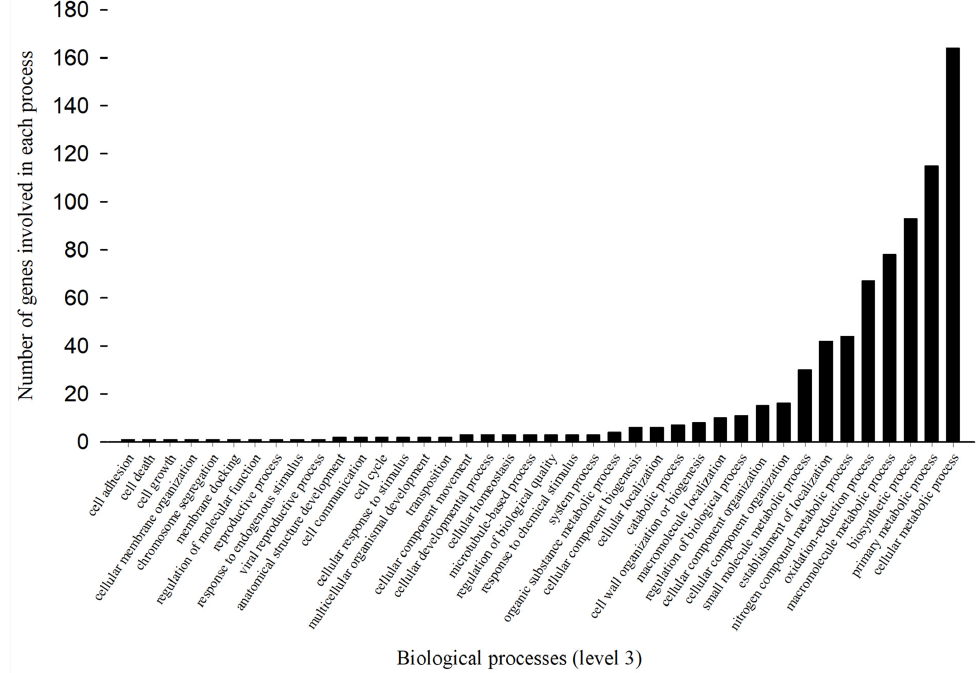
Figure 2. Variable number of up-regulated genes associated with each biological process in permethrin-selected tarnished plant bug.